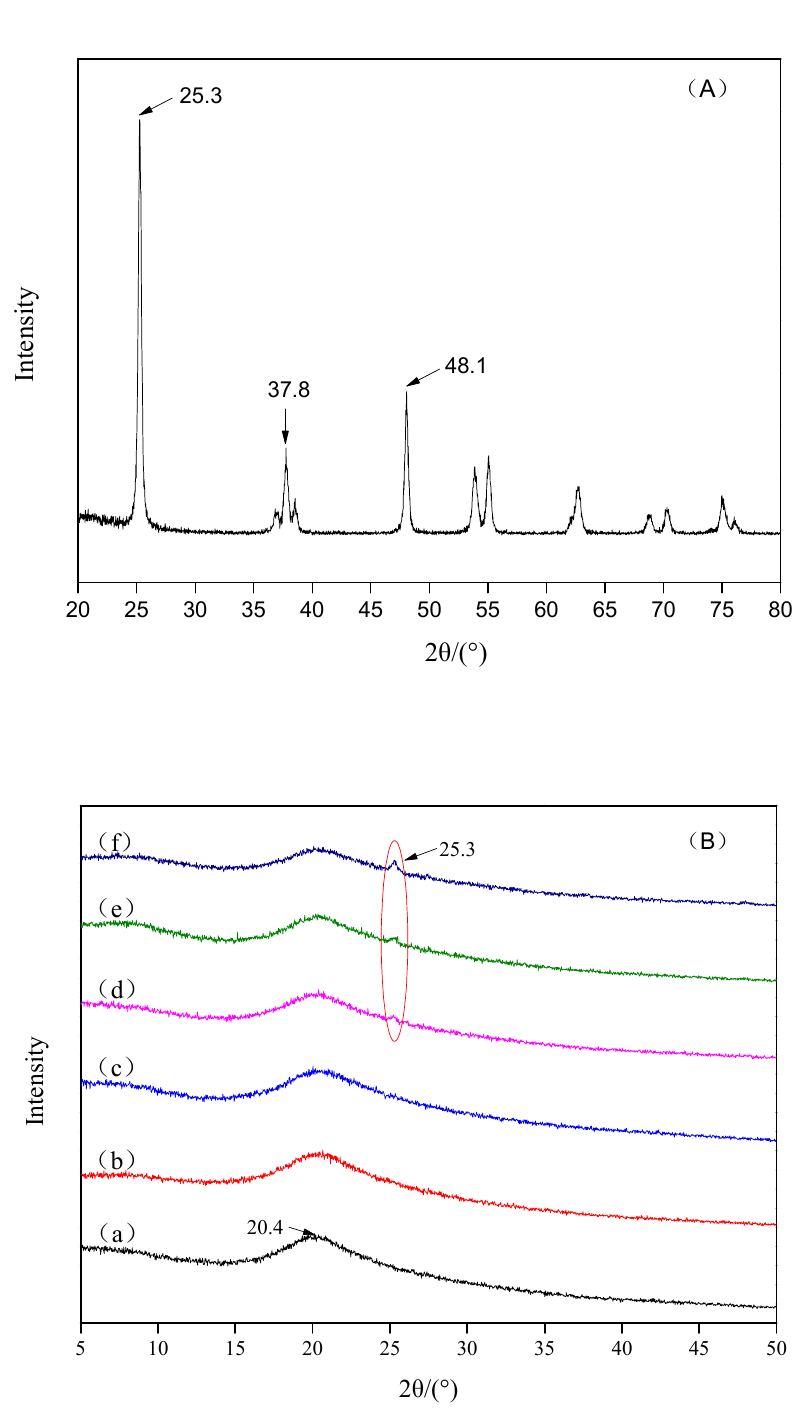
Figure 6. X-ray diffraction (XRD) analysis images for the morphology of original TiO 2 nanoparticles ( A ) and chitosan coating with TiO 2 nanoparticles ( B ) (10 µm × 10 µm; a: 0; b: 0.01%; c: 0.03%; d: 0.05%; e: 0.07%; f: 0.09%).